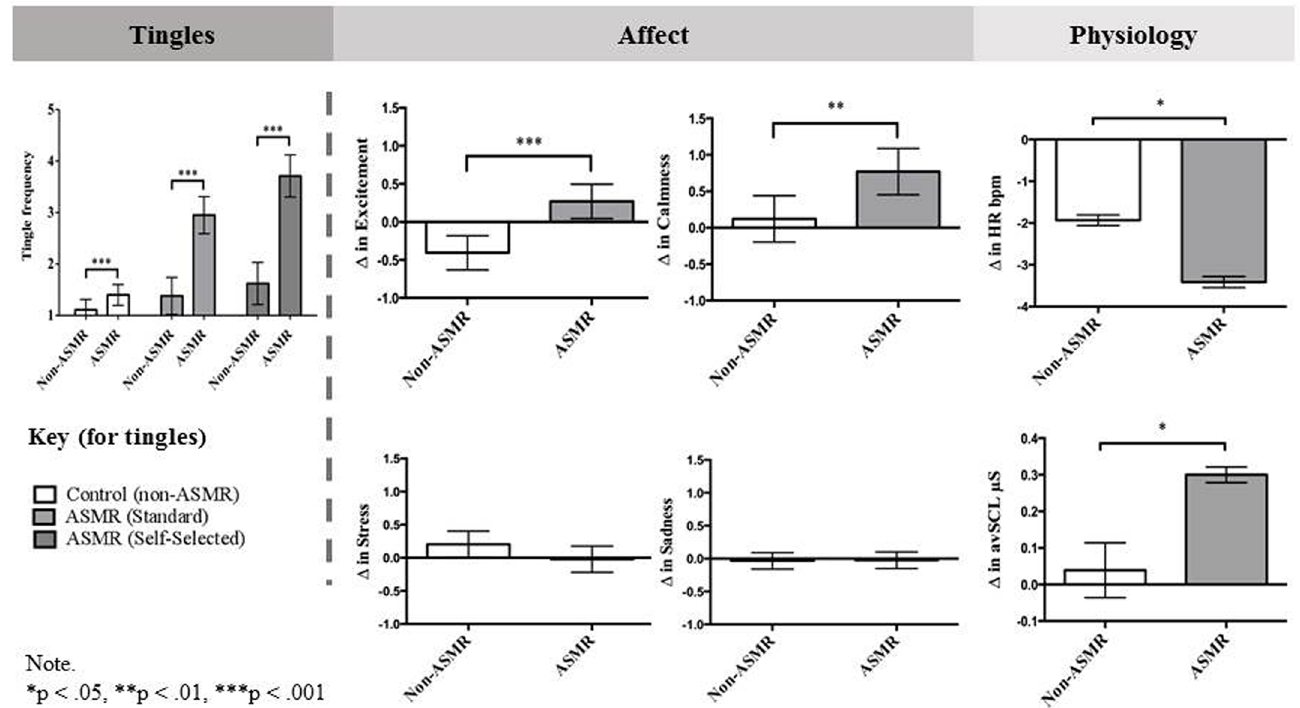
Fig 2. Summary of the results of Study 2 showing differences between ASMR group on self-reported tingles and changes in affect and physiology after watching ASMR inducing videos. For affect and physiology results, the bars show the average changes in affect and physiology, calculated from the difference during watching the control video, collapsed across ASMR inducing videos (i.e. main effect of ASMR group)–dark grey for ASMR participants, white for non- ASMR participants.